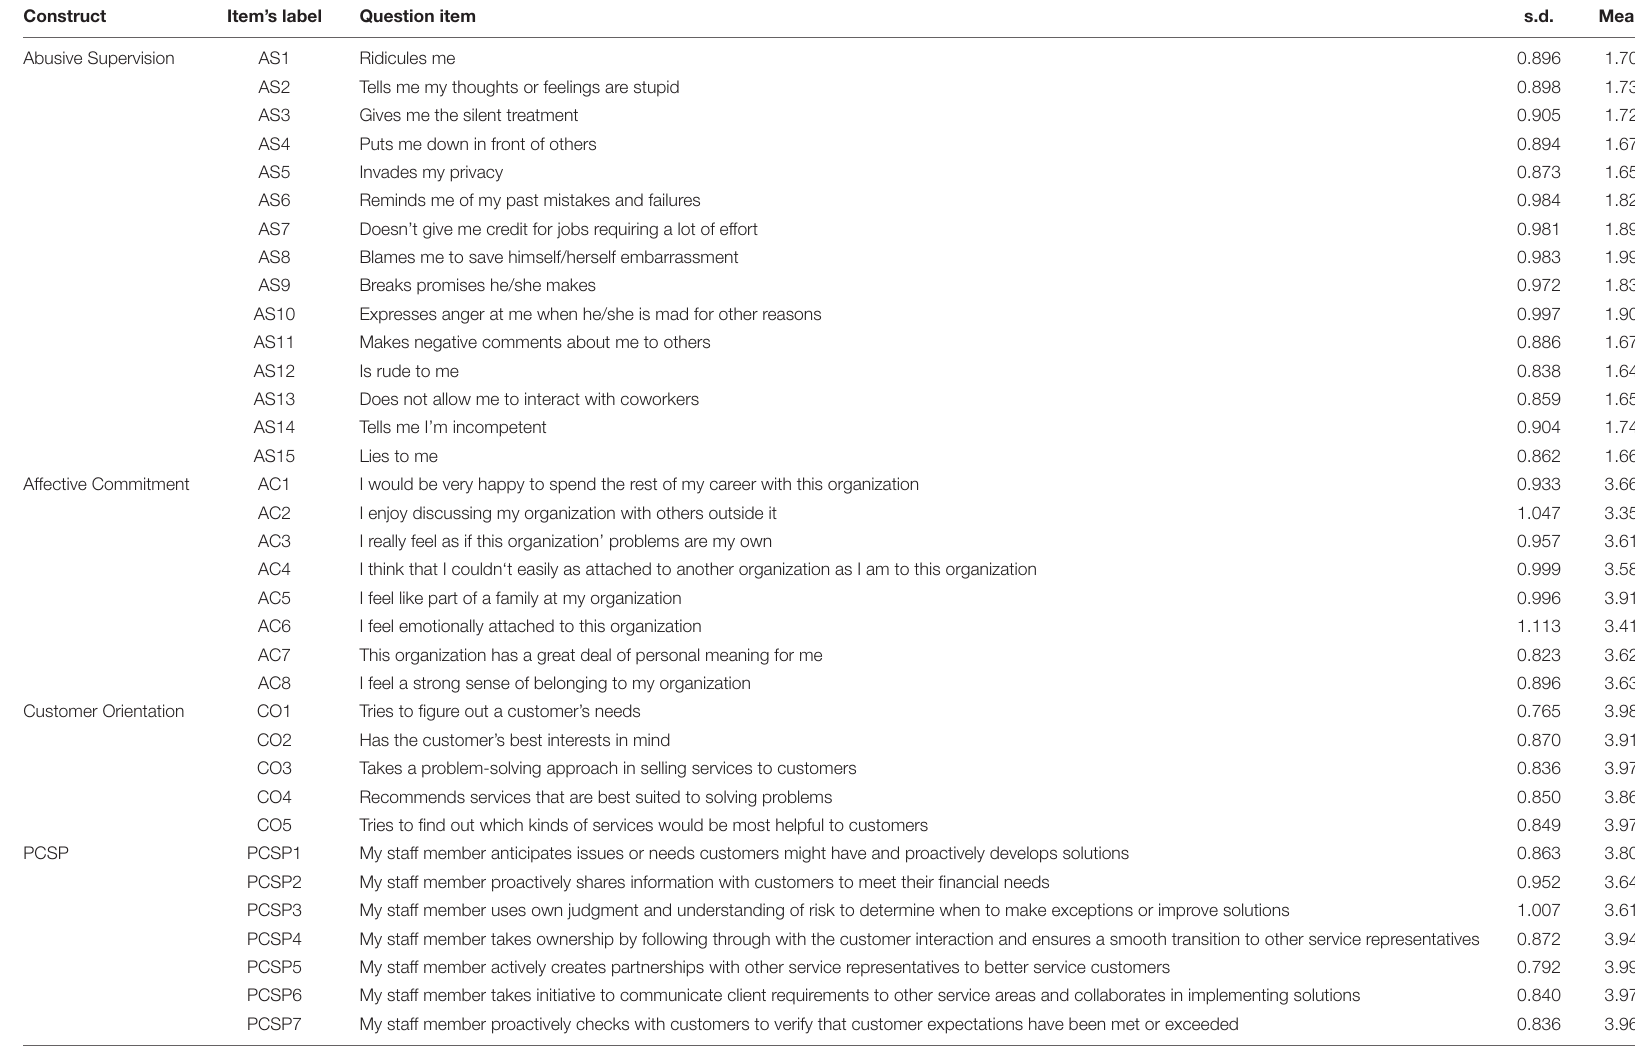
TABLE 1 | Model items and their descriptive statistics (35 items). Construct Abusive Supervision